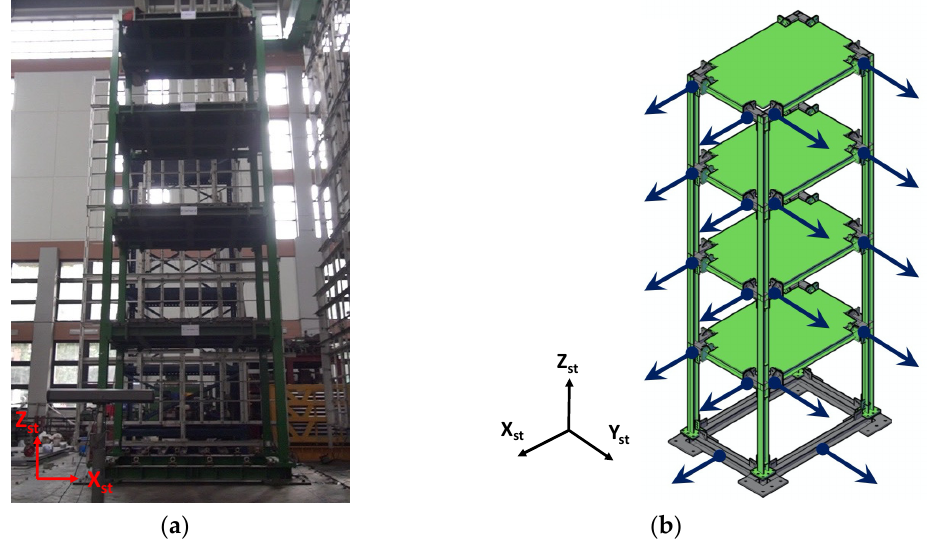
Figure 2. Experimental setup: ( a ) photo captured by camera; ( b ) LVDT locations. Table 1. Parameters for experimental setup.